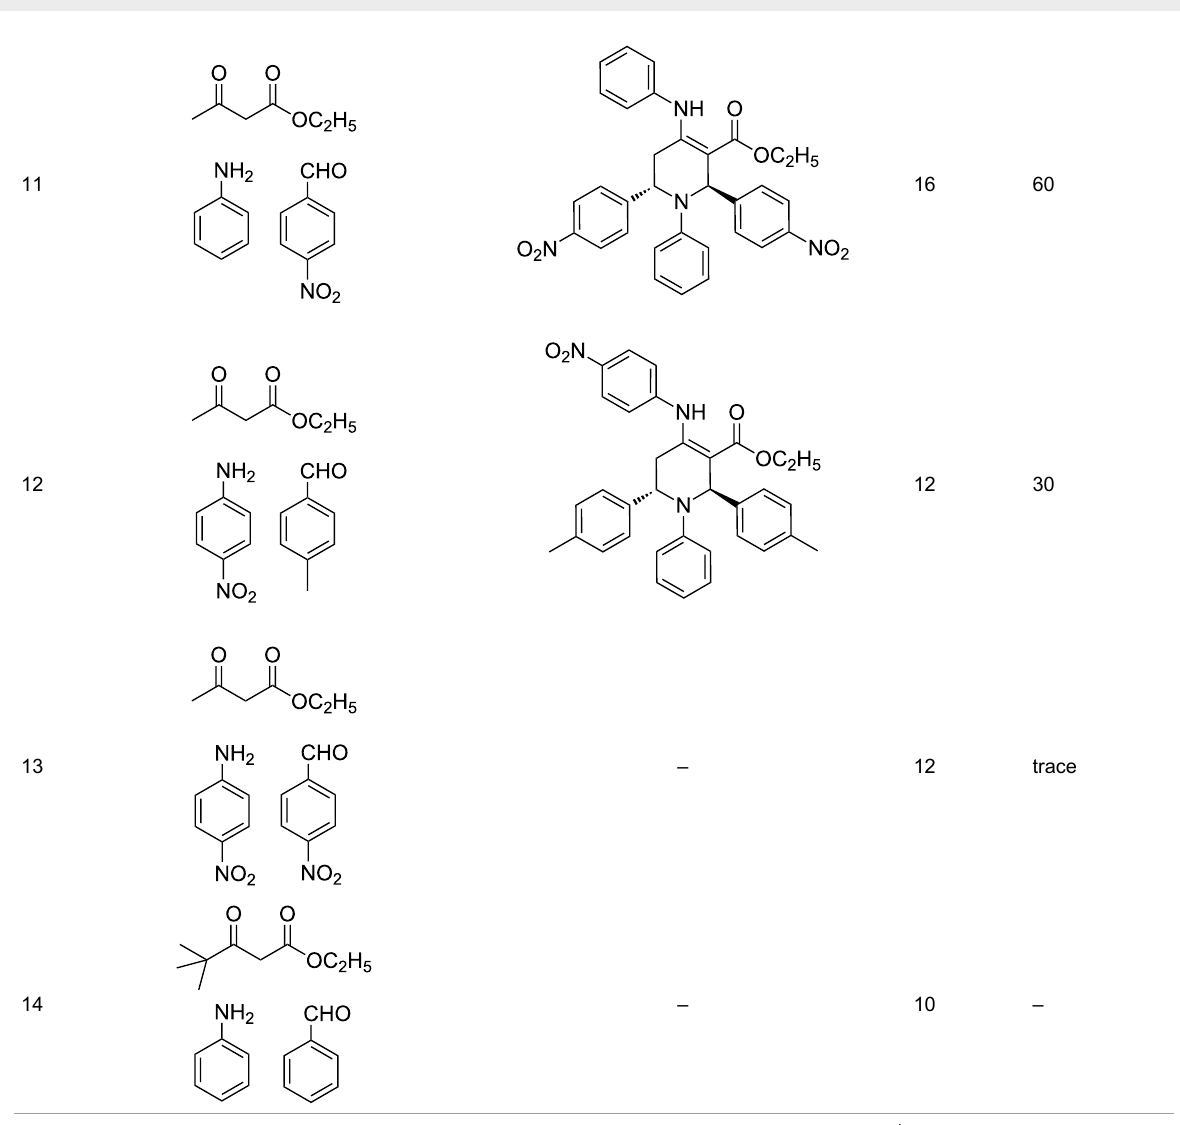
Table 1: Synthesis of functionalized piperidines with [K + PEG]Br 3 − in ethanol. a